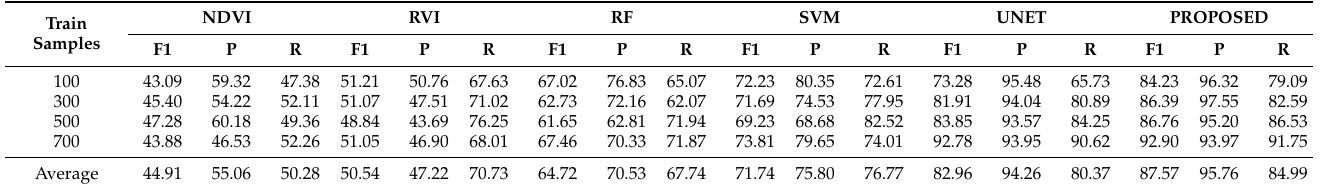
Figure 11. The training curves based on the proposed method and compared supervised learn- ing UNET method, each curve represents the average of 10 times model training following the corresponding method: ( a ) the training accuracy curves; ( b ) the training loss curves. Table 4. Comparison of segmentation among different